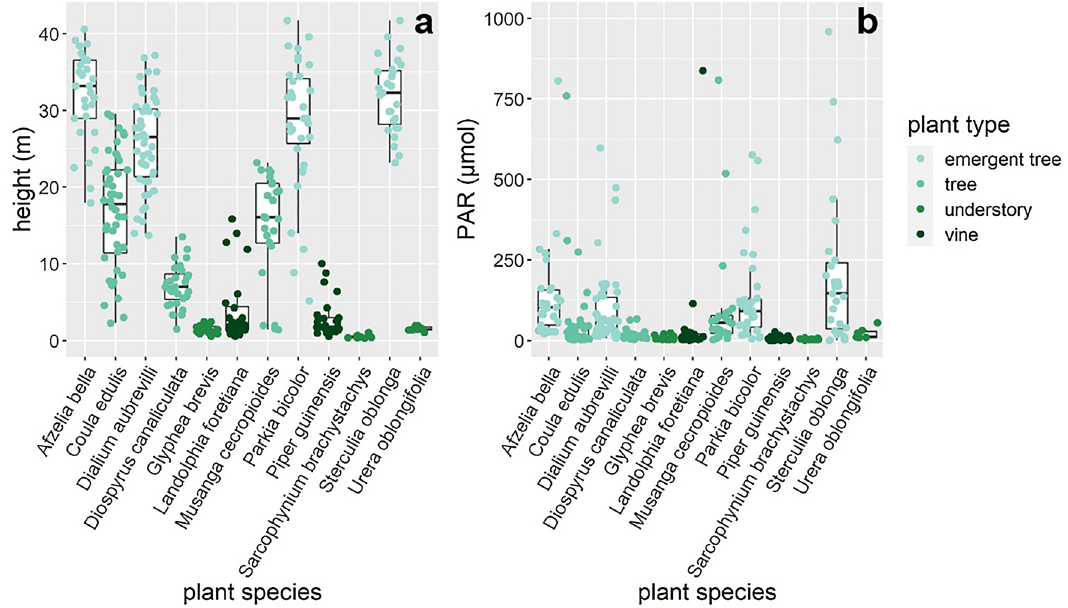
Figure 1. Whisker plots illustrating the effect of plant species on ( a ) leaf sample height and ( b ) photosynthetic active radiation